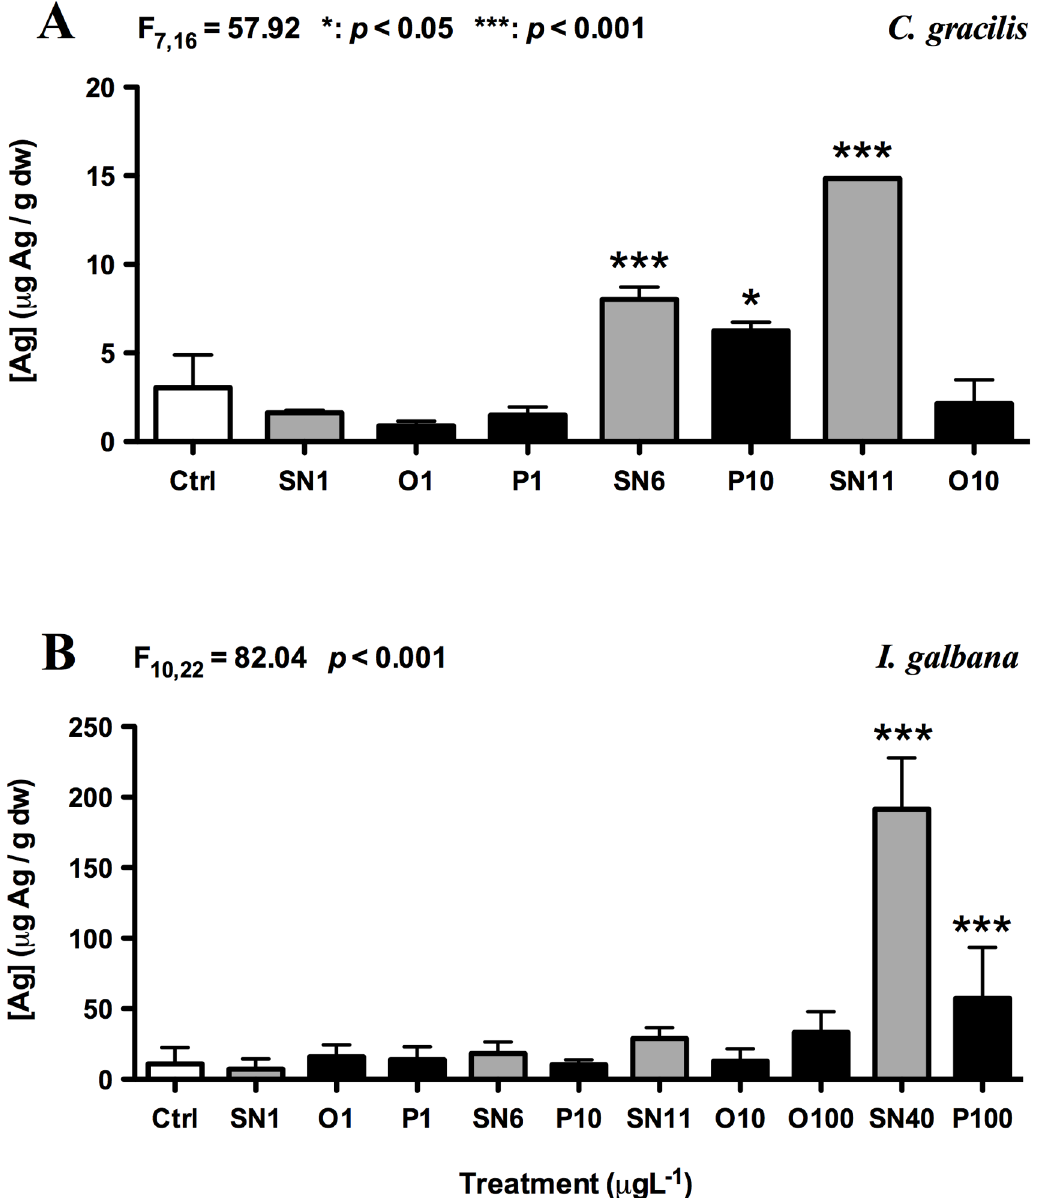
Fig 8. Total silver uptake ( μ g g -1 dw) by C . gracilis (A) and I . galbana (B) after 24 h of exposure. Each bar represents the mean (+ SD) of triplicates. One-way ANOVA was used for the statistics analysis. Significant different between FSW control and treatments was identified by Tukey ’ s test; * : p < 0.05; *** : p < 0.001. Ctrl: FSW control, SN: AgNO 3 , O: OAgNP and P: